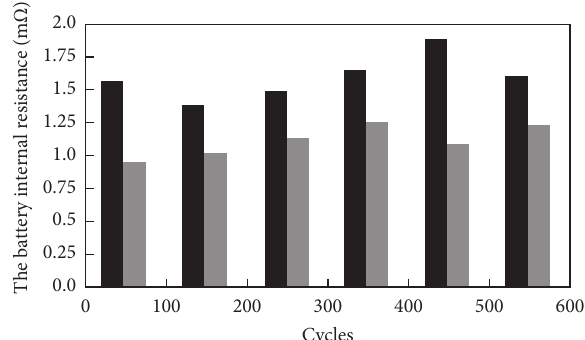
Figure 1: The perennial tendency of the battery.